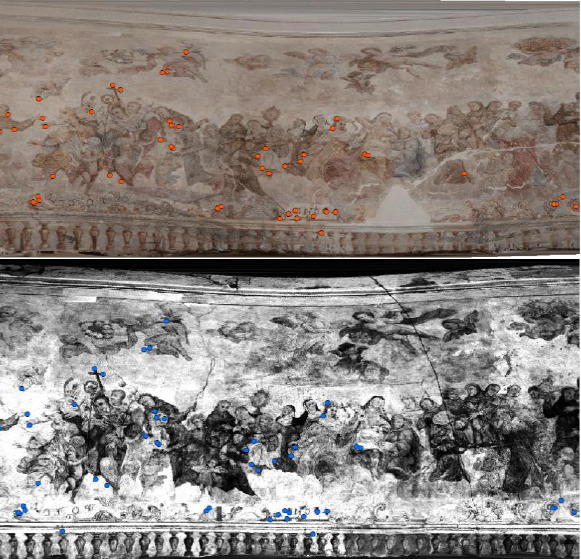
Figure 5: The example of the corresponding points distribution on the fragment of the spherical images.